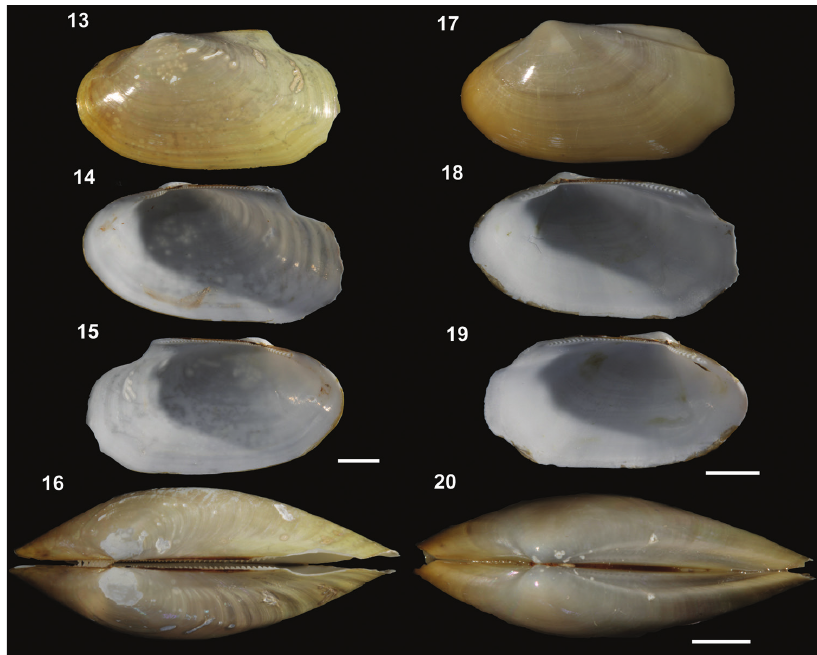
Figure 13–20. 13–16 Malletia alata (Holotype LACM 2343) 13 External view 14–15 Internal view of the shell, right and left respectively 16 Dorsal view (total length = 30 mm) 17–20 Malletia tumaquensis sp. n. 17 External view 18–19 Internal view of the shell, right and left valves, respectively 20 Dorsal view. Scale bars: 0.5